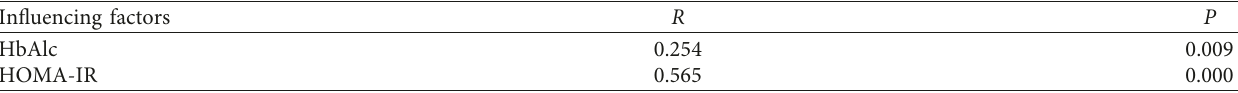
Table 4: Correlation analysis between UACR and individual indicators; UACR was compared after taking the natural logarithm. Influencing factors